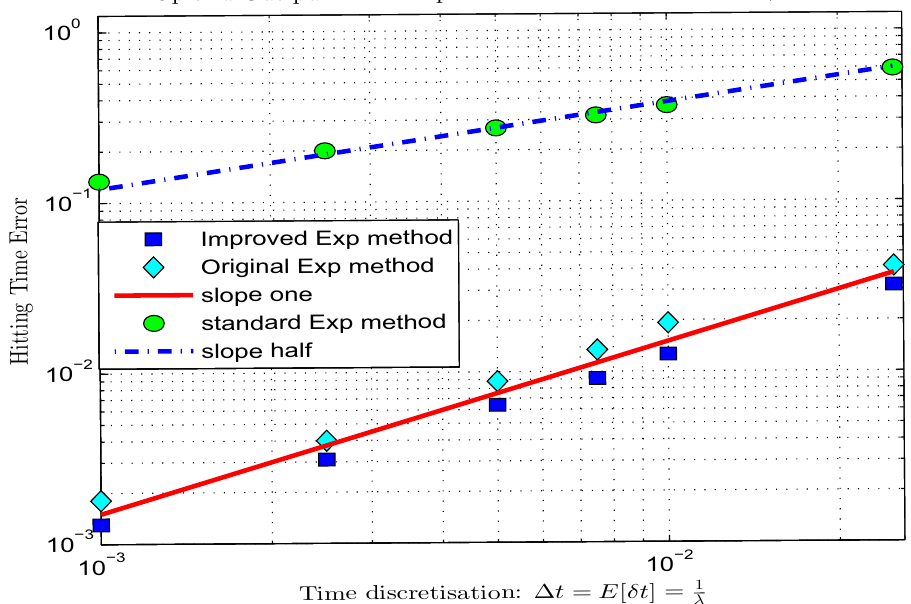
Fig. 2 Plots of the hitting time error calculated using the standard exponential timestepping method, the original exponential method and the improved exponential time stepping algorithm against the discretization parameter (cid:7) t for the up-and-out put barrier option under CEV model. The parameters are fixed as: the volatility parameter at initial time σ 0 = 0 . 40, the dividend q = 0 . 03, the risk-free interest rate r = 0 . 08, the current value of the option S 0 = 100, the strike price K = 100, the barrier H = 130, the elasticity of the local volatility β = 0, and the expiration time T = 1. The theoretical value is 11 . 2713 and the averages are taken over M = 10 7